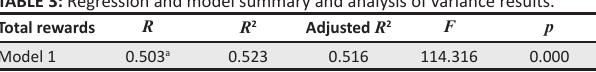
TABLE 3: Regression and model summary and analysis of variance